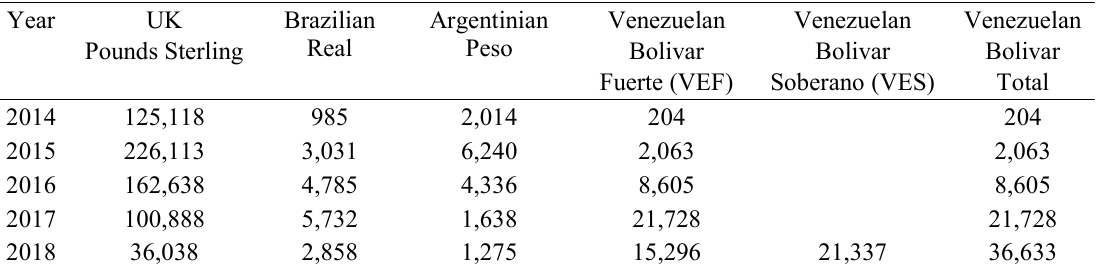
Table 5. Bitcoins Traded: 2014 -